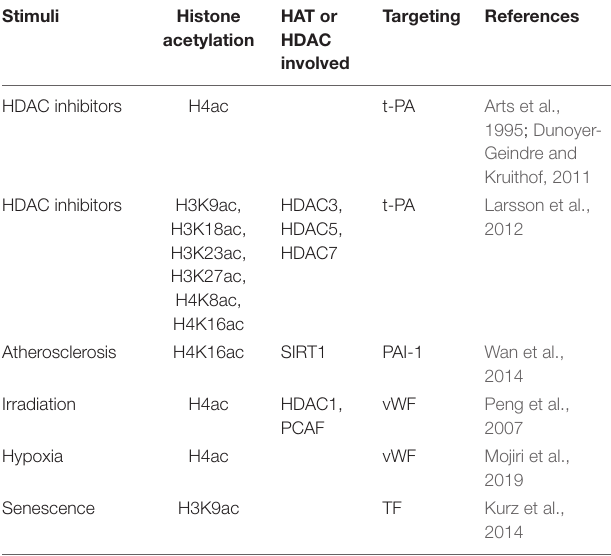
TABLE 6 | Histone acetylation associated with thrombosis and